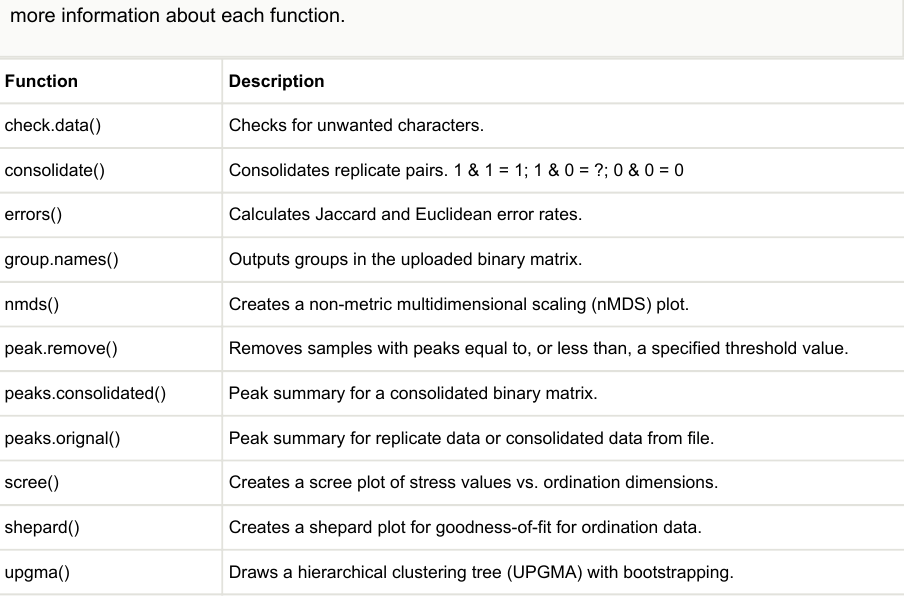
Table 4. BinMat R package functions available on CRAN. Typing ? functionName into the console provides more information about each